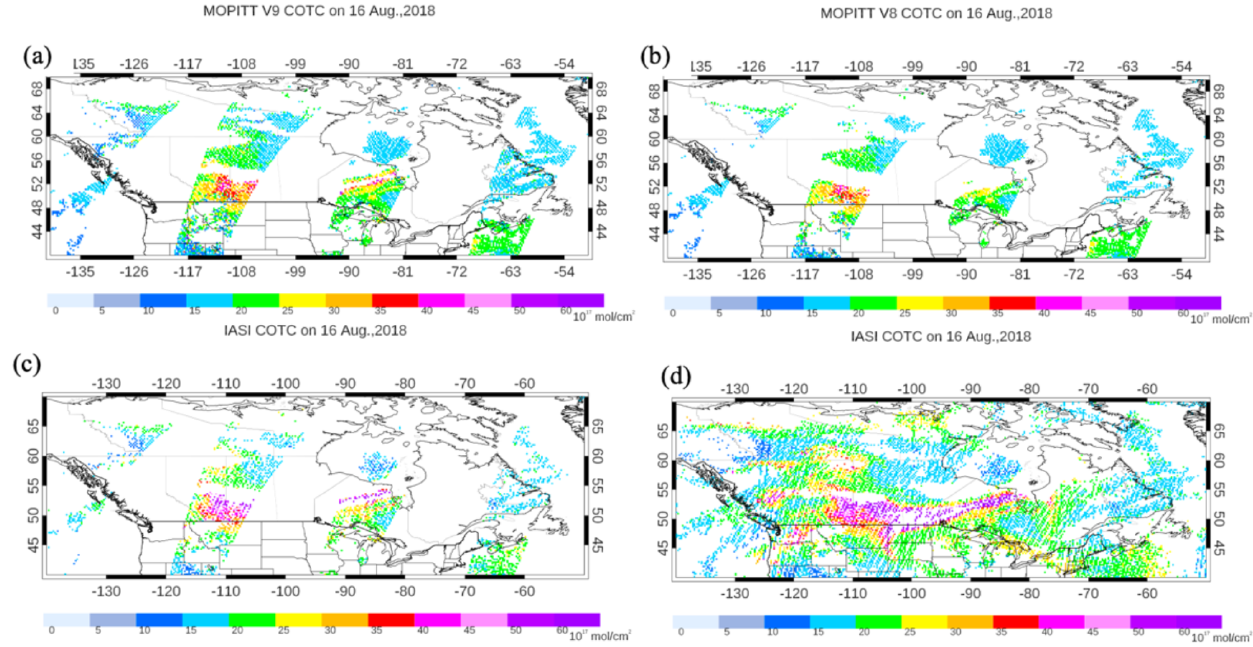
Figure 14. The same as Fig. 10 but for 16 August